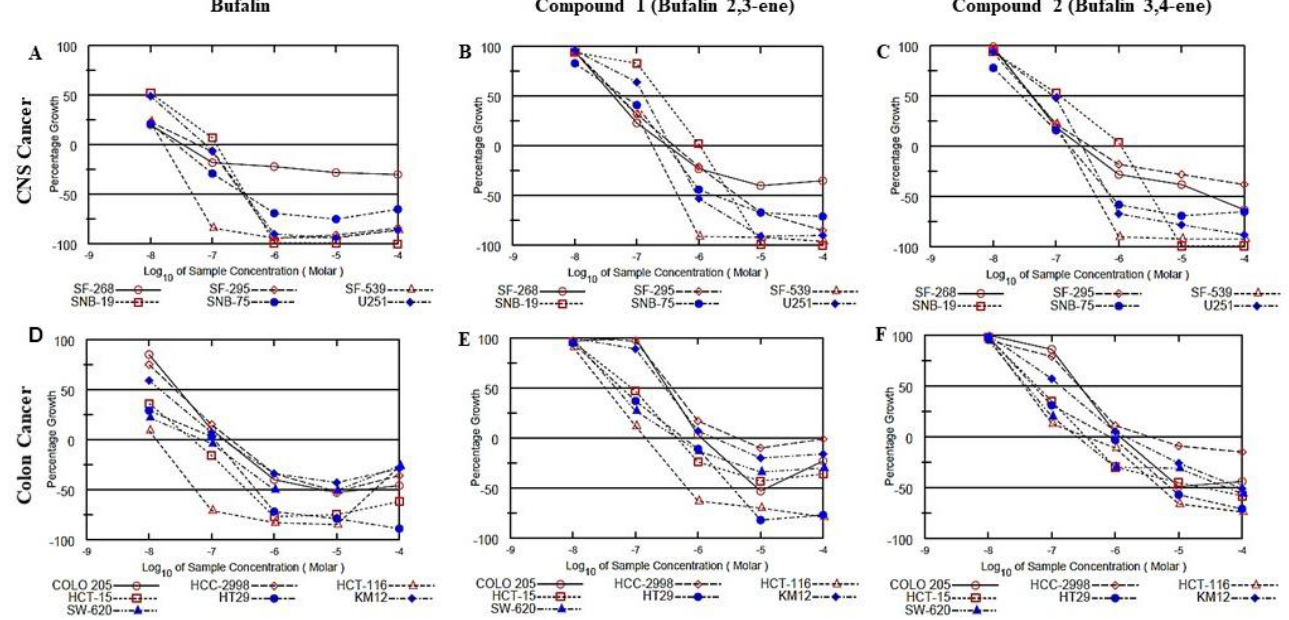
Figure 7. Effect of bufalin, bufalin 2,3-ene, and bufalin 3,4-ene on human cancer cell growth. The anti-proliferative activity of the steroids was tested against the NCI-60 cell line panel at the National Cancer Institute (NCI), Bethesda, Maryland, USA according to their standard protocol (https://dtp.cancer.gov/discovery_development/nci-60/methodology.htm, 27 March 2022). The effects of bufalin and the novel bufalin derivatives on 6 glioblastoma cell lines ( A – C ) and 7 colorectal cancer cell lines ( D – F ) are shown.